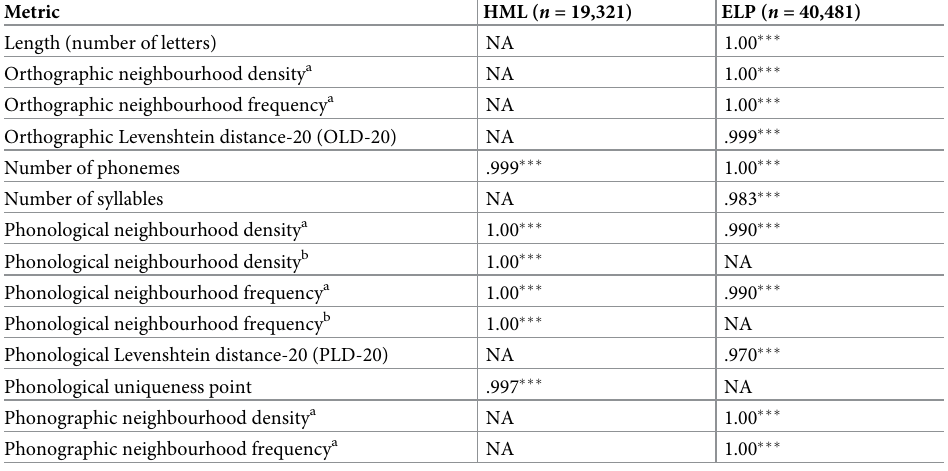
Table 5. Pearson correlation coefficients for the metrics computed by LexiCAL, and the data in the Hoosier Men- tal Lexicon (HML) and the restricted English Lexicon Project (ELP). Metric